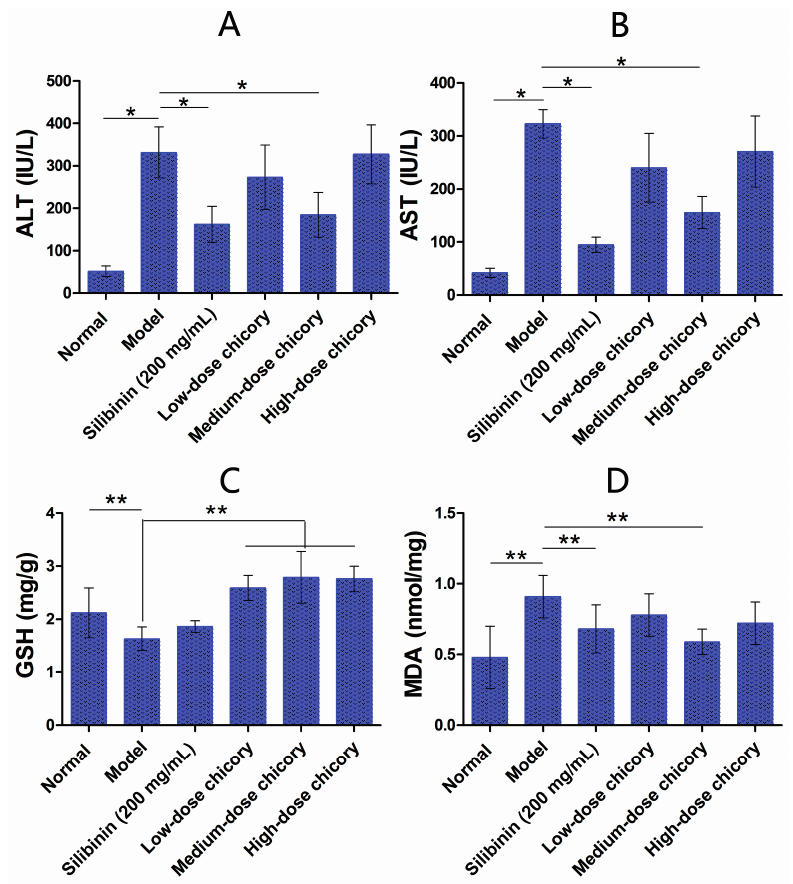
Figure 1. ( A ) Serum ALT (alanine aminotransferase) level in mice; ( B ) serum AST (aspartate aminotransferase) level in mice; ( C ) liver tissue GSH (glutathione) level in mice; and ( D ) liver tissue MDA (malondialdehyde) level in mice. * , p < 0.05; ** , p <